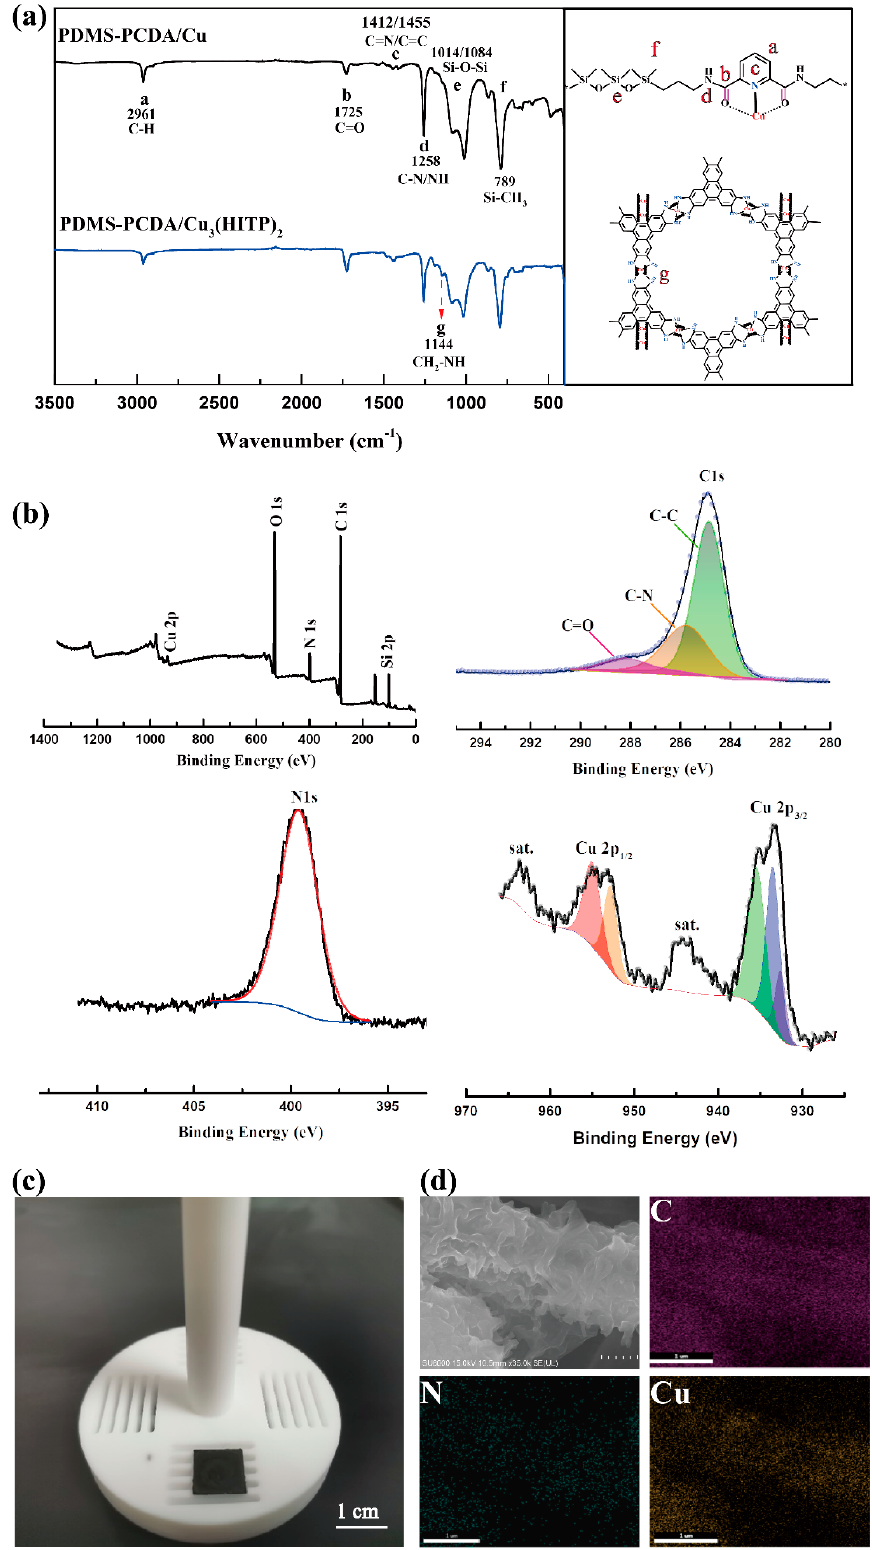
Figure 3. Characterization of PDMS-PCDA/ Cu 3 (HITP) 2 NFAs. ( a ) FT-IR of PDMS-PCDA/Cu NFAs (black) and PDMS-PCDA/Cu 3 (HITP) 2 NFAs (blue). ( b ) XPS of PDMS-PCDA/Cu 3 (HITP) 2 NFAs, focusing on N1s, C1s, and Cu2p. ( c ) Photograph of the PDMS-PCDA/Cu 3 (HITP) 2 fiber arrays on the (n++) Si substrate. ( d ) SEM/EDX mapping images of PDMS-PCDA/Cu 3 (HITP) 2